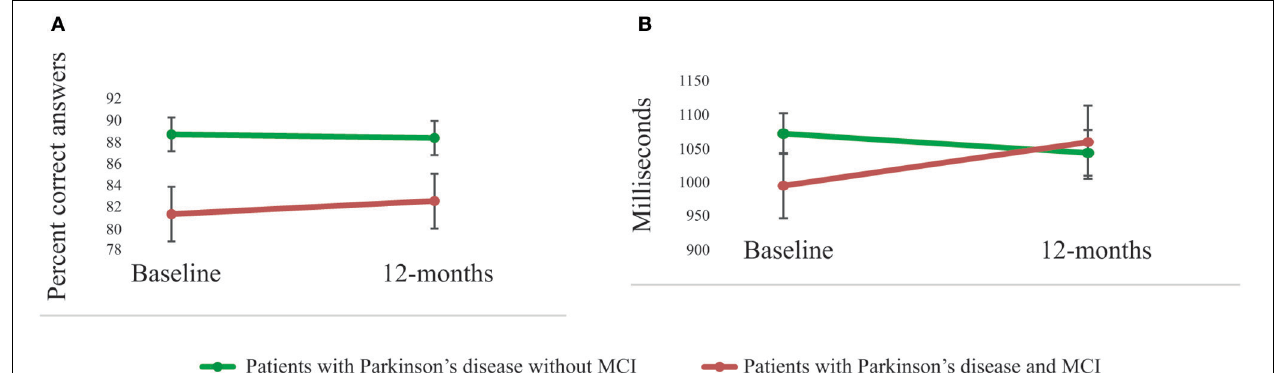
FIGURE 2 | Performances on the scanner working-memory task. (A) A significant ( p = 0 . 01) main effect of group in performance accuracy was shown with superior performances for patients with Parkinson’s disease without MCI compared to patients with MCI. The